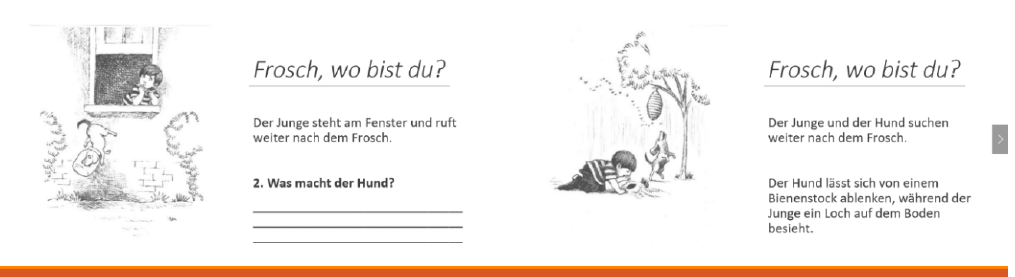
Figure A5. Pretest: Production task.